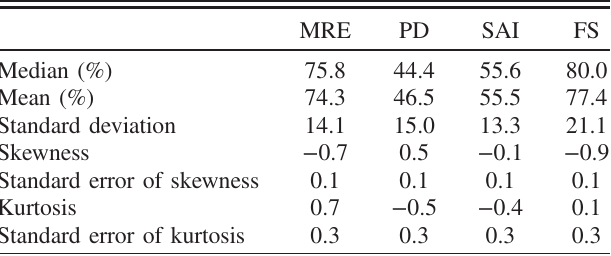
TABLE VI. Results of students ’ ASES responses, ranging from 20% to 100% (as the response scale is 1 to 5).